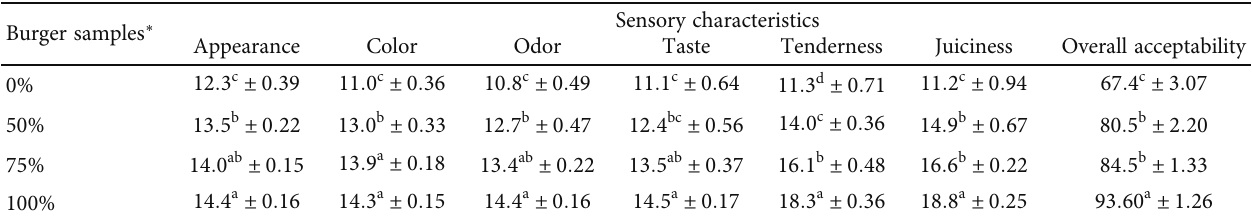
Table 9: Sensory characteristics of roasted camel meat burger a ff ected by replacing fat with di ff erent levels (%) of UBDF pulp. Burger samples ∗